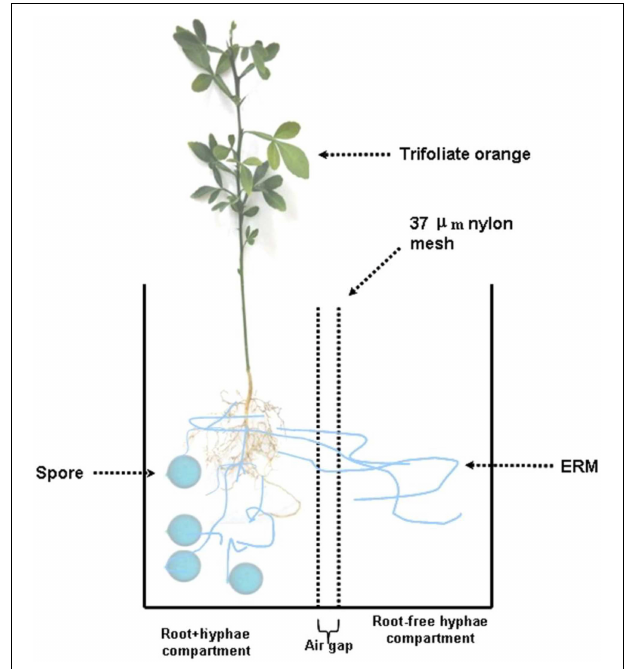
FIGURE 1 | Schematic diagram of a two-compartment rootbox system to grow trifoliate orange seedlings. The rootbox was divided into root + hyphae compartment and root-free hyphae compartment through 37– µ m nylon mesh, which has the ability to allow mycorrhizal hyphae, but not roots, to enter the compartment. An air gap (1cm width) was created using two layers of nylon mesh to avoid additional diffusion between root + hyphae and hyphae compartments. Two trifoliate orange seedlings were planted in the root + hyphae compartment, where Funneliformis mosseae was